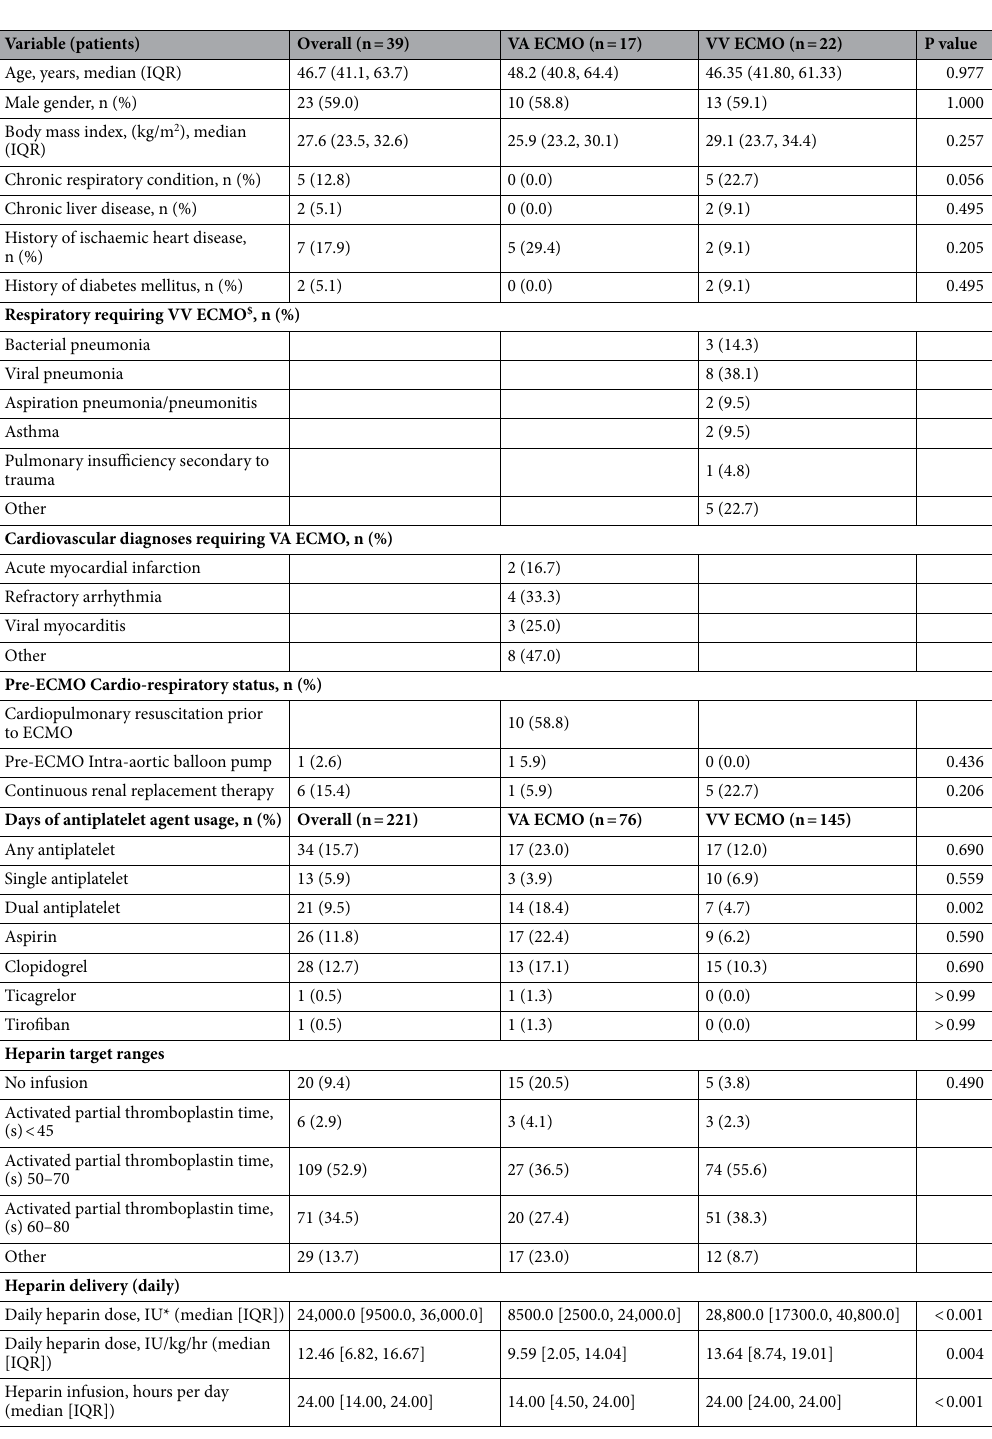
Table 1. Patient characteristics and heparin